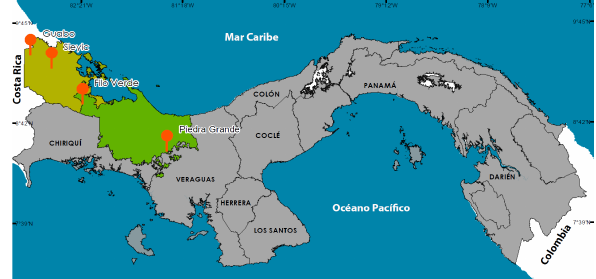
Figure 1. Map of location of the comunidades (I.